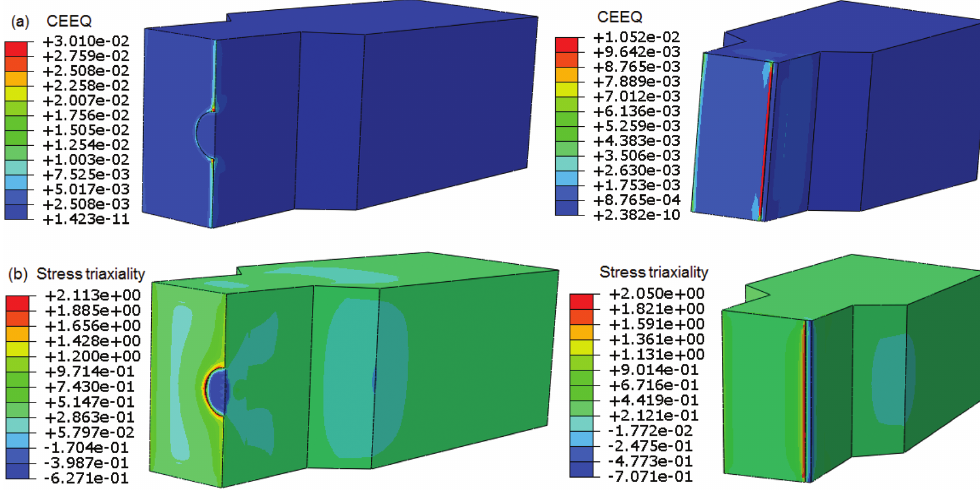
Figure 7: The CEEQ (a) and stress triaxiality (b) distribution for straight and semicircular defects.